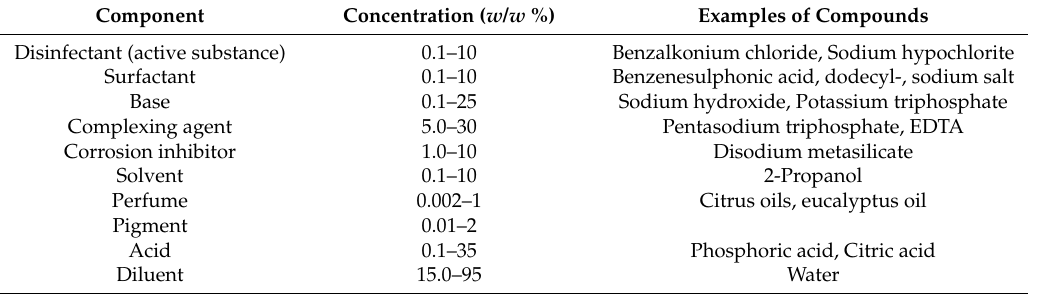
Table 2. Usual composition of cleaning products